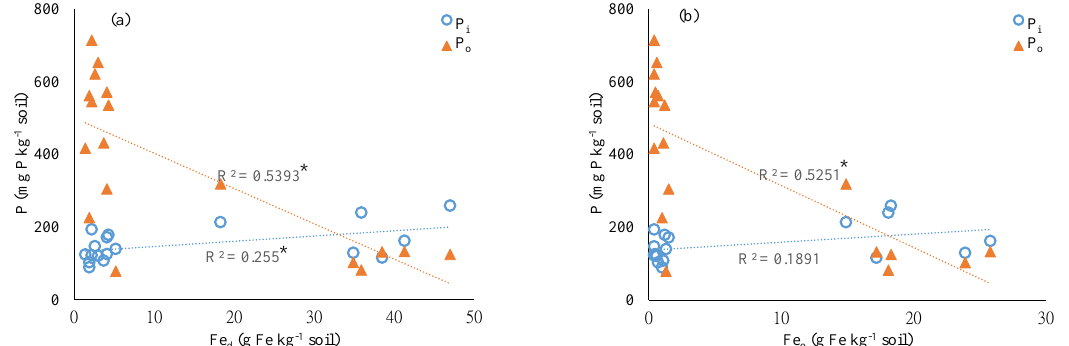
Figure 1. Correlations of contents of P i and P o with Fe d ( a ) and Fe o ( b ) in the pedon samples collected from the three sampling sites. * Statistically significant at p < 0.05.